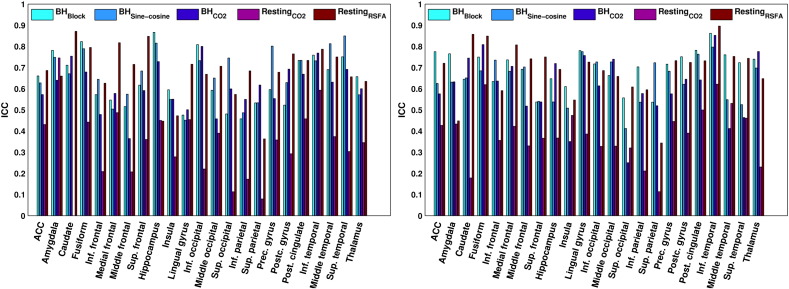
The repeatability (ICC) of the estimated vascular reactivity for each of the methods in each region of interest in the left hemisphere (left) and right hemisphere (right). An ICC of < .40 indicates “poor” repeatability, .40–.59 “fair” repeatability, .60–.74 “good” and > .74 “excellent” repeatability.